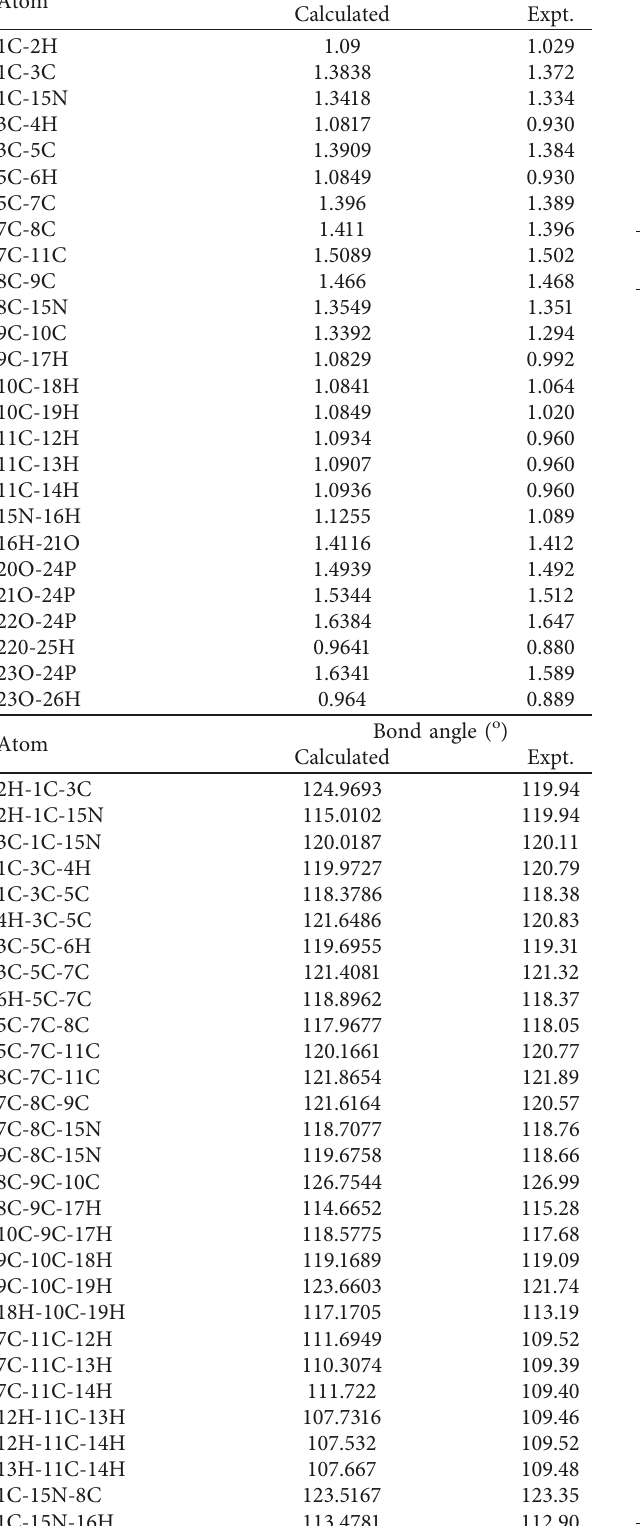
Table 1: Selected bond parameters of 3M2VPP. Bond distance (˚A) Atom Calculated